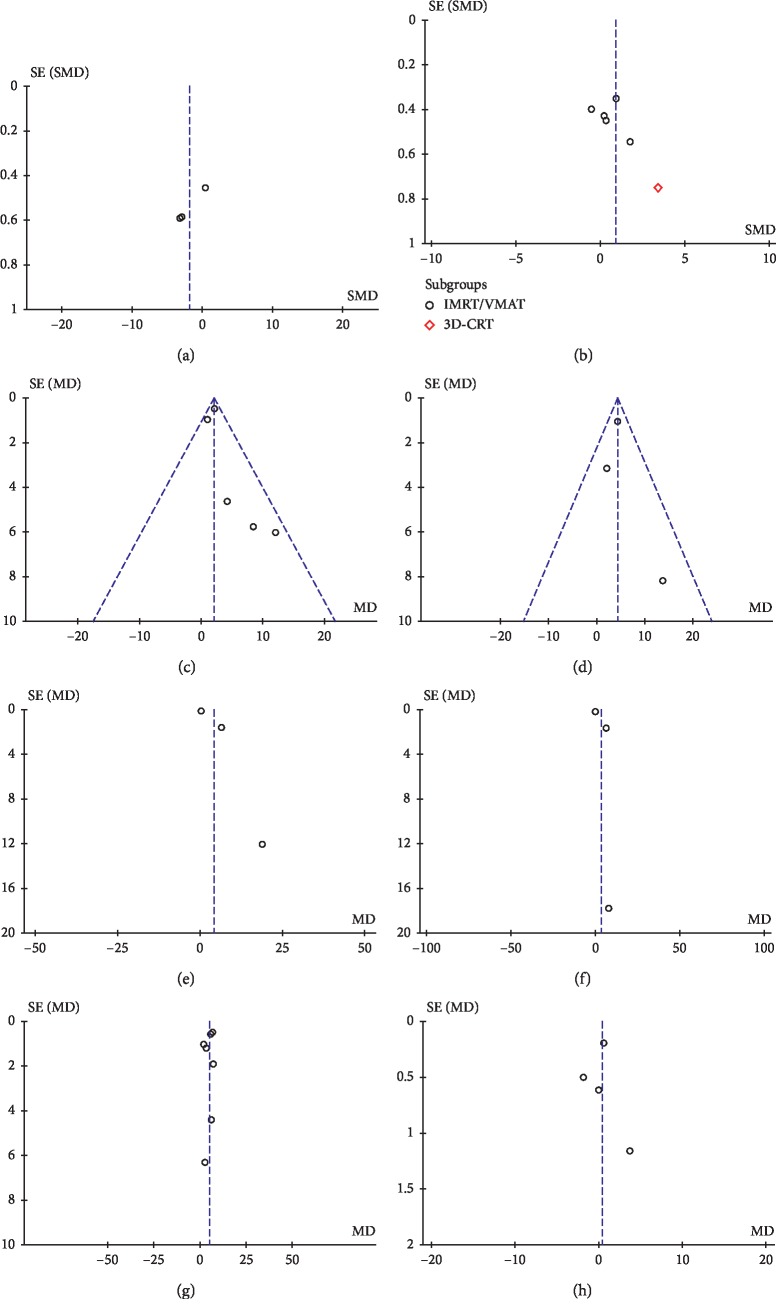
Funnel plots for target and intracranial OARs. (a) Conformity Index. (b) Homogeneity Index. (c) Dmean of the brainstem. (d) Dmean of the optic chiasm. (e) Dmean of the left cochlea. (f) Dmean of the right cochlea. (g) Dmean of the normal brain. (h) Dmax of the normal brain.